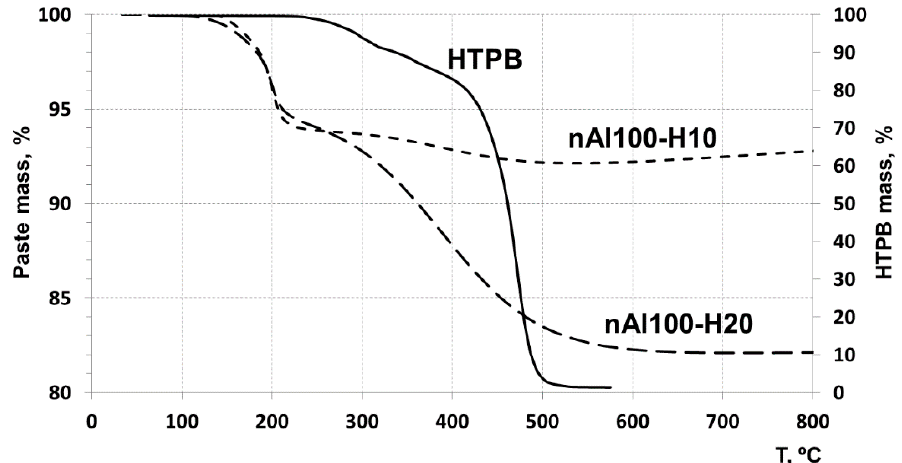
Figure 4. TGA of HTPB and nAl / HTPB pastes in Ar (10 ◦ C / min).